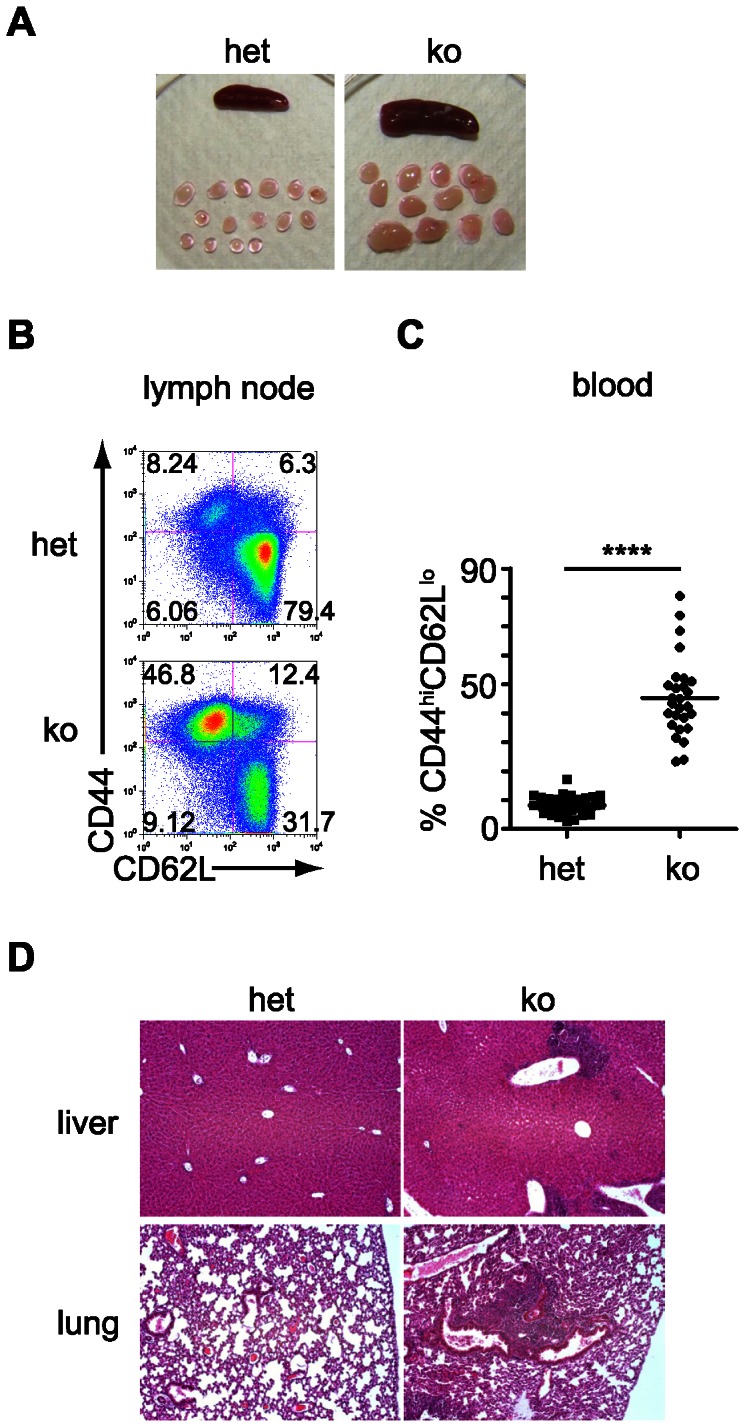
Mice with Treg lacking canonical miRNAs develop scurfy-like disease.Macroscopic (a), flow cytometric (b,c) and histologic (d) analysis of the disease spontaneously occurring in FoxP3-GFP-hCre:DGCR8lox/lox (KO) mice. FoxP3-GFP-hCre:DGCR8wt/lox (het) served as control mice. (a) Splenomegaly (top) and lymphadenopathy (bottom) in het and KO mice. (b) Lymph nodes (LN) were harvested from ≥3 week old het and KO mice. Single cell suspensions stained with anti-CD44 and anti-CD62L to determine activation of CD4+ Tconv (gated on CD4+GFP−) as an indirect readout of Treg function were analyzed by flow cytometry (FACS). The increased frequency of CD44hiCD62Llo cells among CD4+GFP− lymphocytes represents spontaneous activation of Tconv in lymph node cells. Representative FACS plots from >10 independent experiments. (c) Quantification of frequency of activated CD44hiCD62Llo among CD4+GFP− Tconv in peripheral blood of 3–4 week old mice. n = 35 (het), n = 27 (KO). p<0.0001 (Two-tailed Mann-Whitney Test). (d) Representative paraffin-embedded sections of liver and lung tissues stained with Hematoxylin & Eosin of het and KO mice. Pictures were taken with 100×optical magnification. 4/4 KO livers and 4/4 KO lungs had infiltrates, 0/4 het livers or lungs were infiltrated.